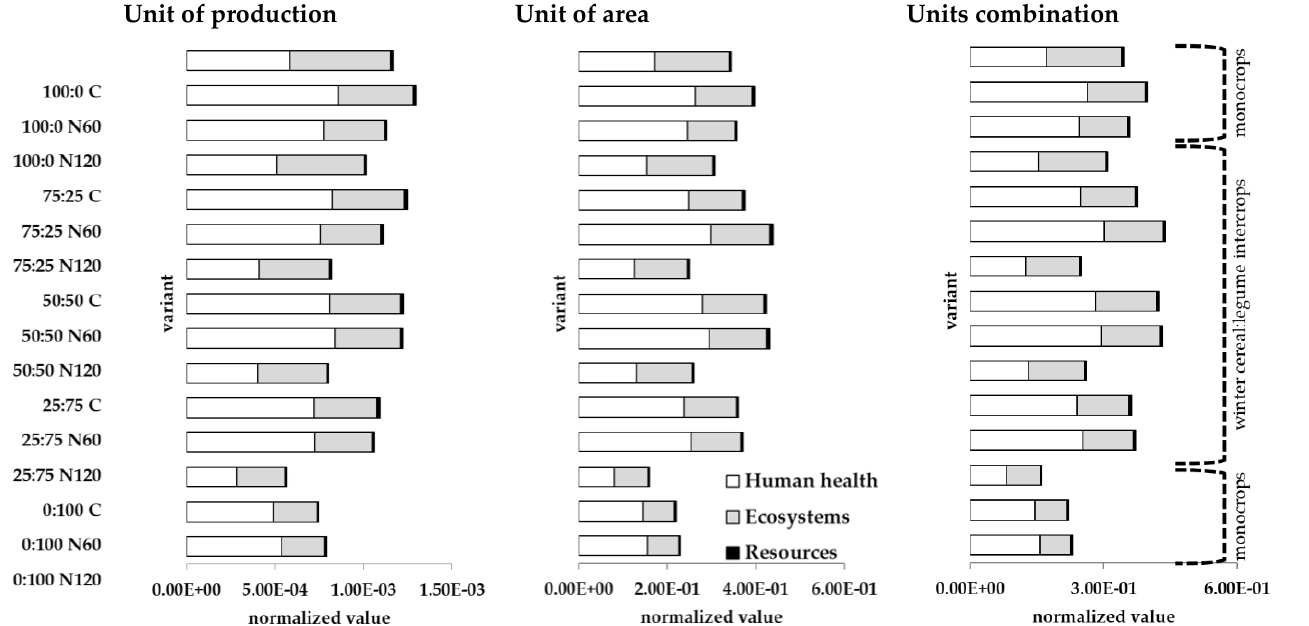
Figure 5. Trends of the environmental impact (the combination of the unit of production; grain N yield respectively, and the unit of area; land demand for generating the same N yield, respectively) ; C = Control; N60 = variant with input of 60 kg N ha − 1 ; N120 = variant with input of 120 kg N ha − 1 ; Sowing ratios of oat:pea (%:%): 100:0, 75:25, 50:50, 25:75, and 0:100; Based on Normalization model; ReCiPe 2016 Endpoint (H) V1.05/World (2010) H/Official; Endpoint category: Resources, Ecosystems, Human health .